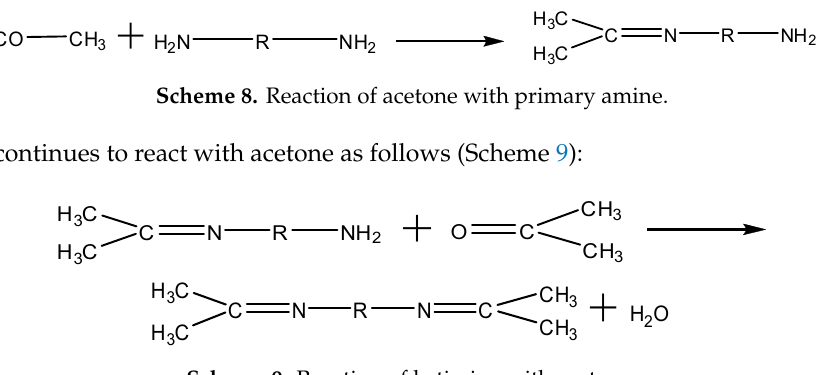
Scheme 9. Reaction of ketimine with acetone.